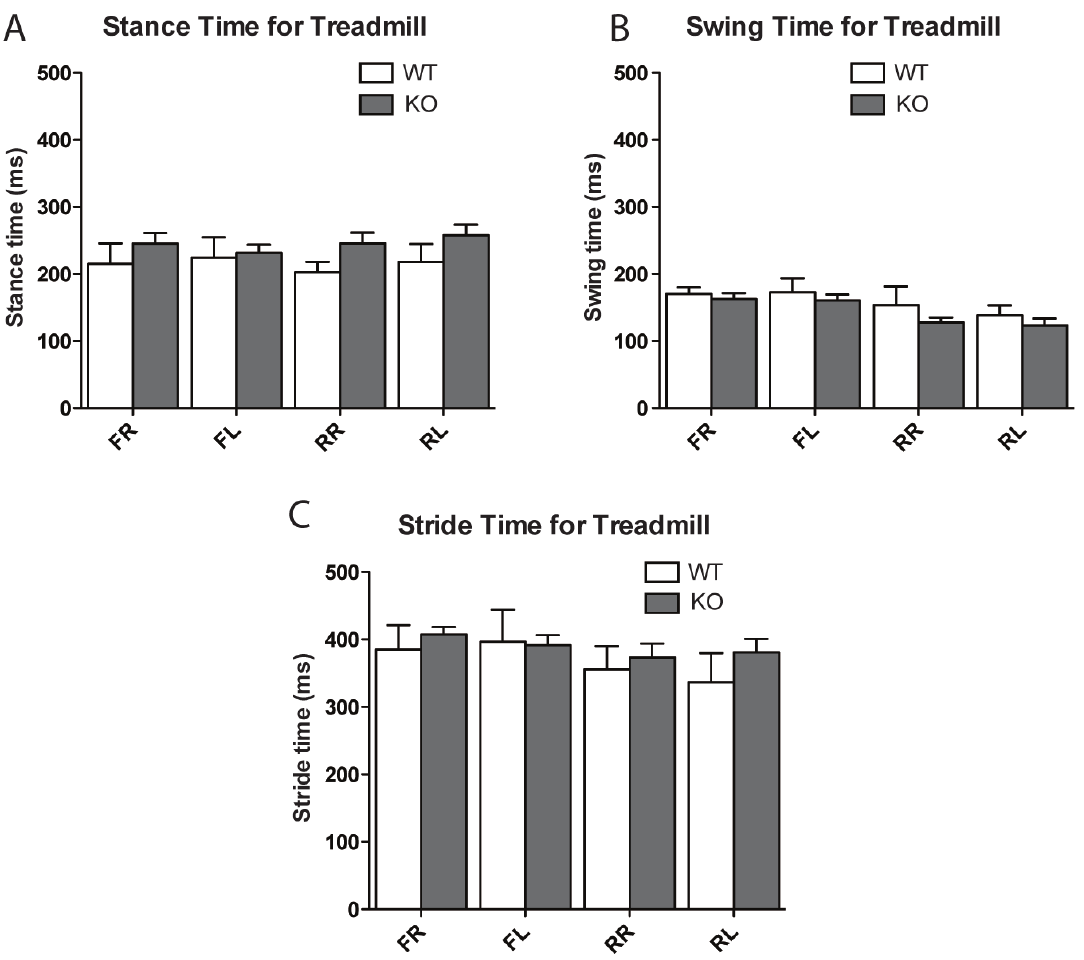
Figure 3. No phenotypic difference of ANP32E-deficient mice in forced stride gait. Mouse gait analysis was performed on a treadmill and analysed for stance time (panel A), swing time (panel B) and stride time (panel C). Values for separate legs are presented separately. FR , front right; FL , front left; RR , rear right; RL , rear right.